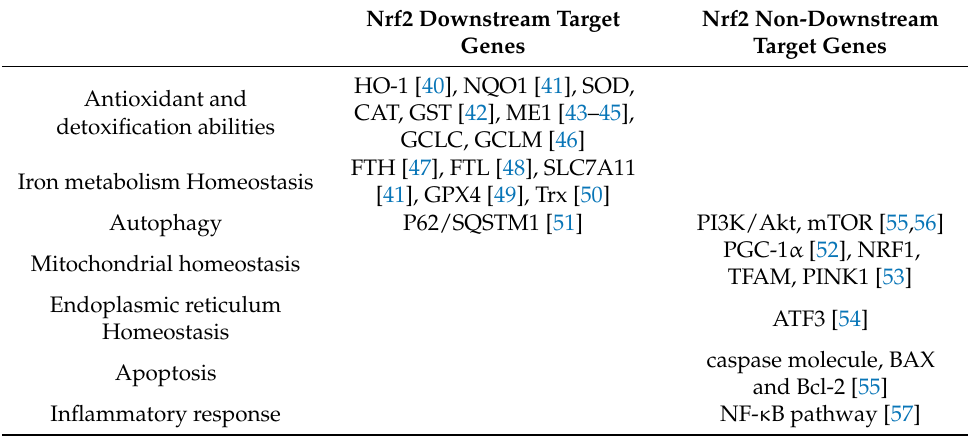
Table 1. Nrf2 downstream target genes and non-downstream target